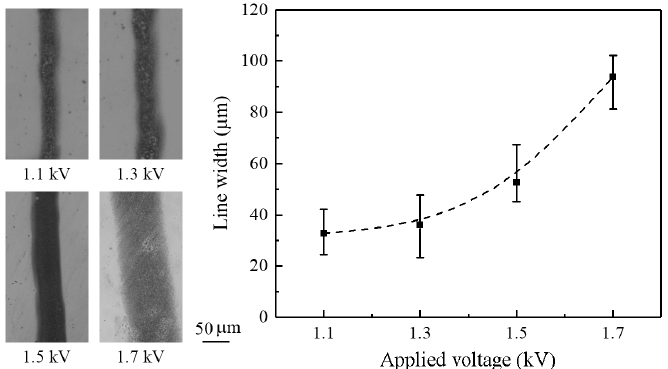
Figure 7. The effect of applied voltage on line width. The flow rate is 100 μ L/h, and the nozzle-to-substrate distance is 0.5 mm.